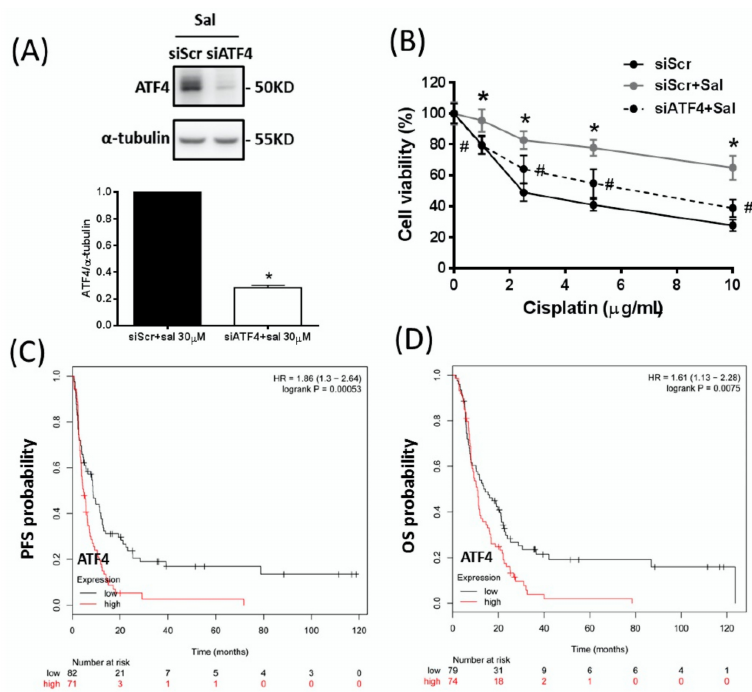
Figure 2. ATF4 plays an essential role in salubrinal-induced cisplatin resistance in gastric cancers